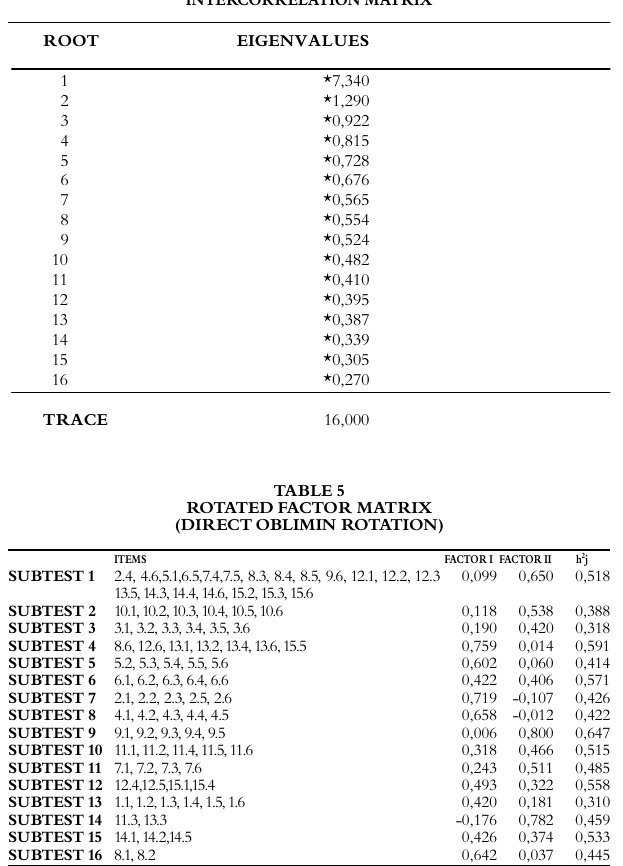
TABLE 4 EIGENVALUESOF UNREDUCED